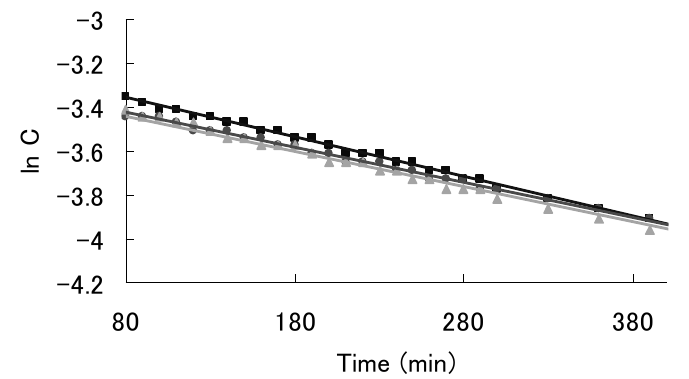
Figure 3. Time profile of the concentration of the zwitterions 7 ( ■ ), 9a ( ● ), and 9b ( ▲